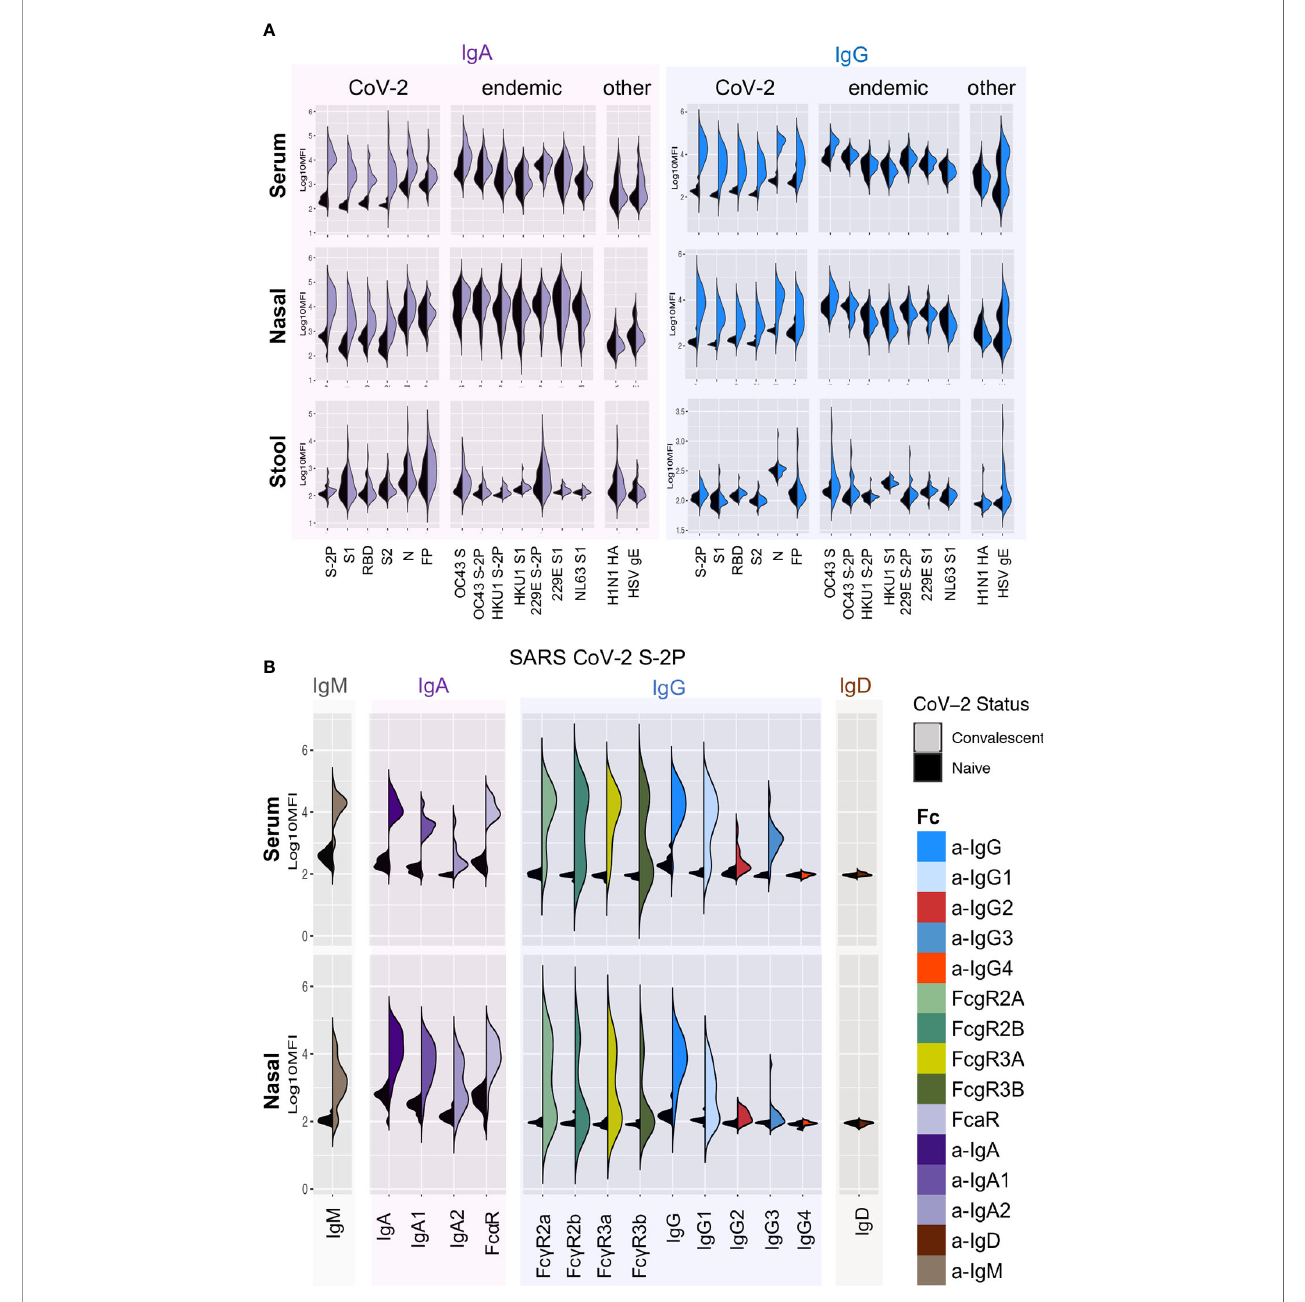
FIGURE 1 | Systemic and mucosal Ab responses. (A) Fc array characterization of IgA (left) and IgG (right) responses against a panel of SARS-CoV-2, other CoV, and control antigens in serum (top), nasal wash (middle), and stool (bottom) from convalescent (colored) and naïve (black) donors. (B) Isotypes, subclasses, and FcR binding of Abs to stabilized SARS CoV-2 S (S-2P) in serum (top) and nasal wash